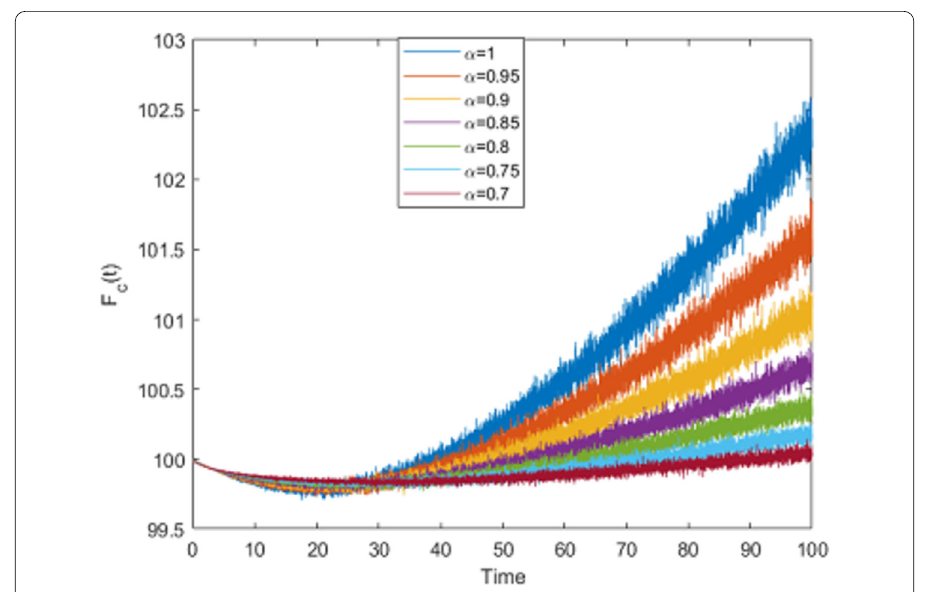
Figure 14 The class of researchers susceptible for σ 1 =